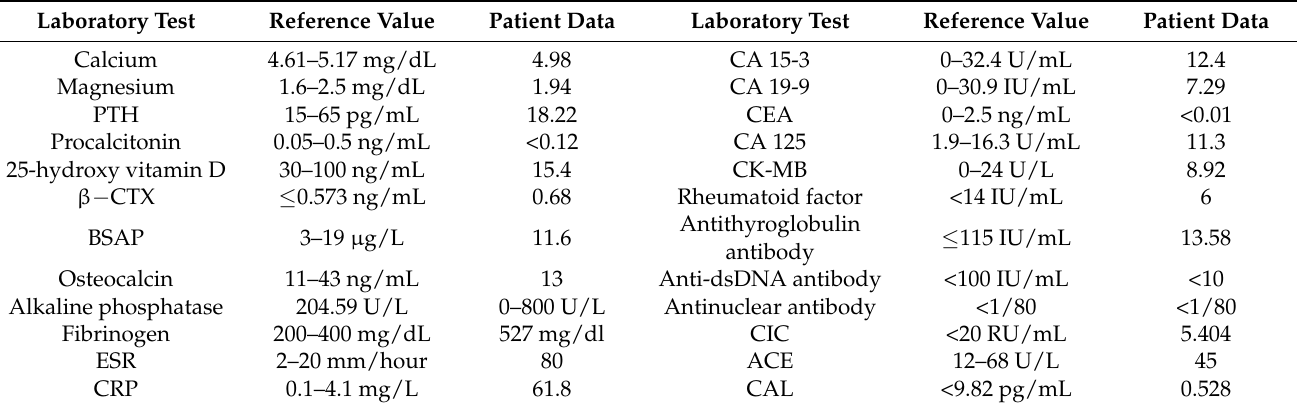
Table 1. Laboratory tests .